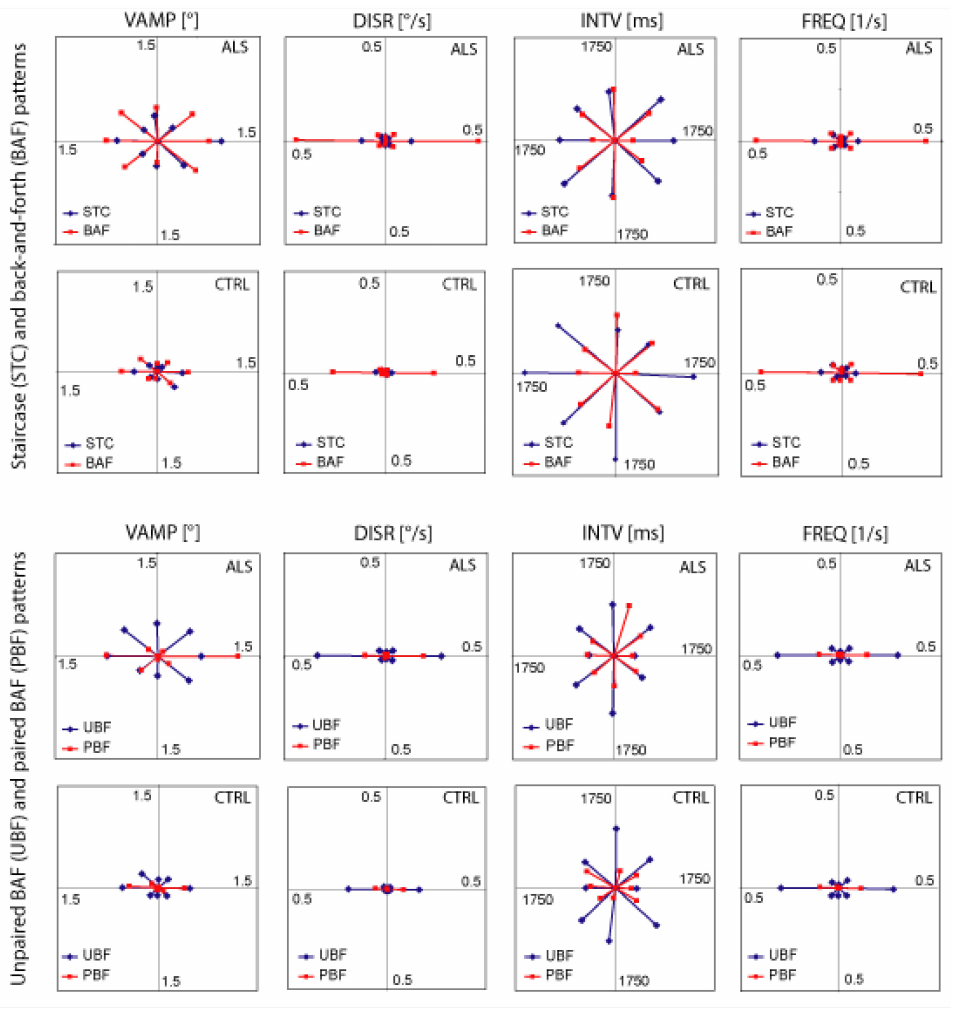
Fig. 3 Vectorial represen tation of intrusion parameters of ALS patients (1 st and 3 rd row of panels) and controls (2 nd and 4 th row). Upper half of figure shows results from stair case ( STC , blue symbols) and back-and-forth ( BAF , red) patterns; lower half, separate analysis of unpaired ( UBF , blue) and paired ( PBF , red) BAF intrusions, respectively. 1 st column of panels, VAMP (vectorial amplitude, average of individual me dians); 2 nd , DISR (displacement rate, average of individual sums of vectorial amplitu des per unit of time); 3 rd , INTV (interval between first and second component of pattern, average of indivi dual medians); 4 th , FREQ (frequency of occurrence, average of individual frequencies). Vector orientations reflect the average direction of the intrusions within each sector of